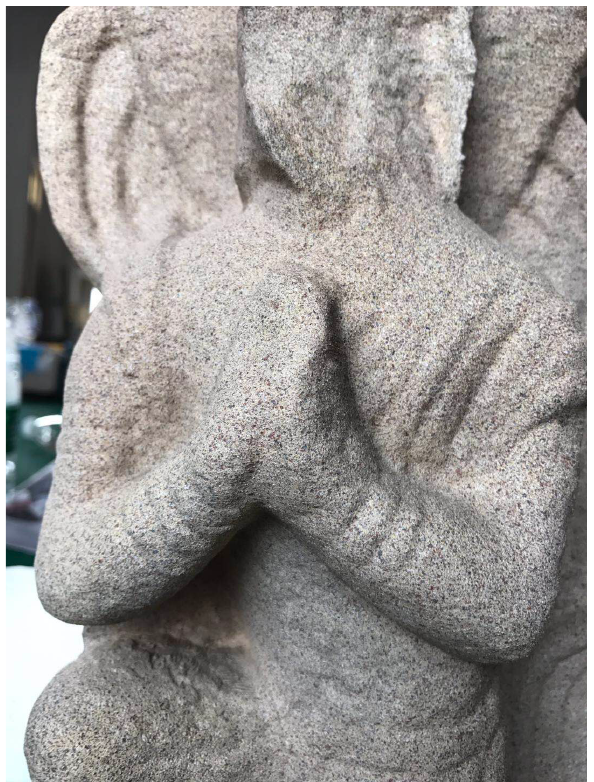
Figure 11. The details of the Replica Cave